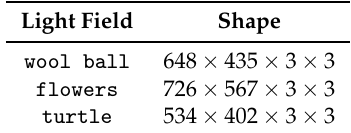
Table 5. Actual light-field data set.